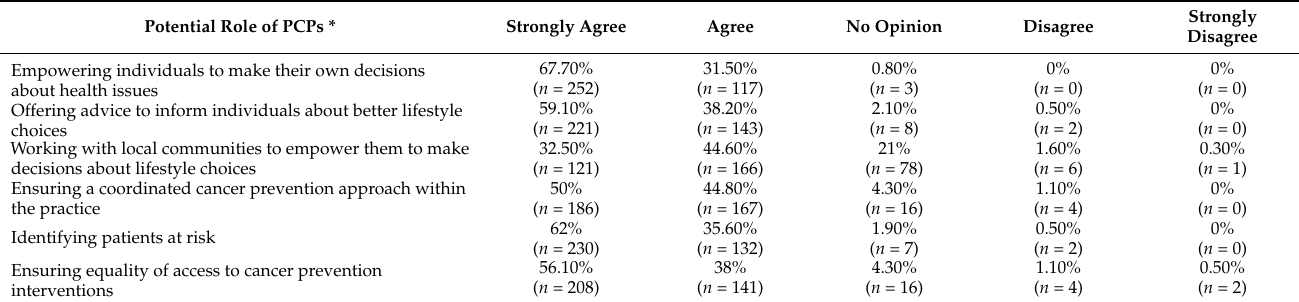
Table 3. Potential role of Primary Care Physicians in the prevention of cancer.